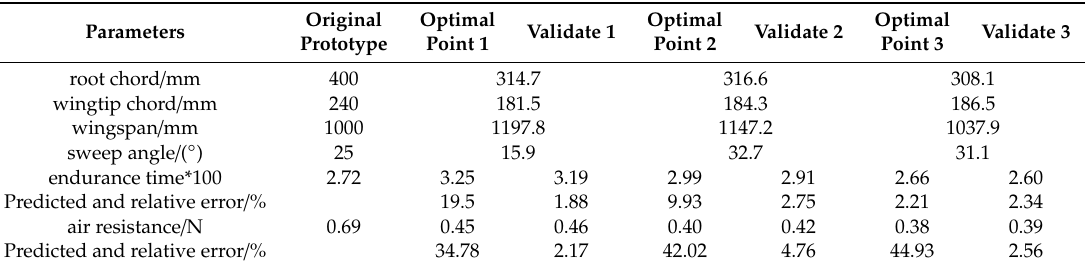
Figure 16. Multi-objective genetic algorithm (MOGA) optimization. Table 3. The optimal structural